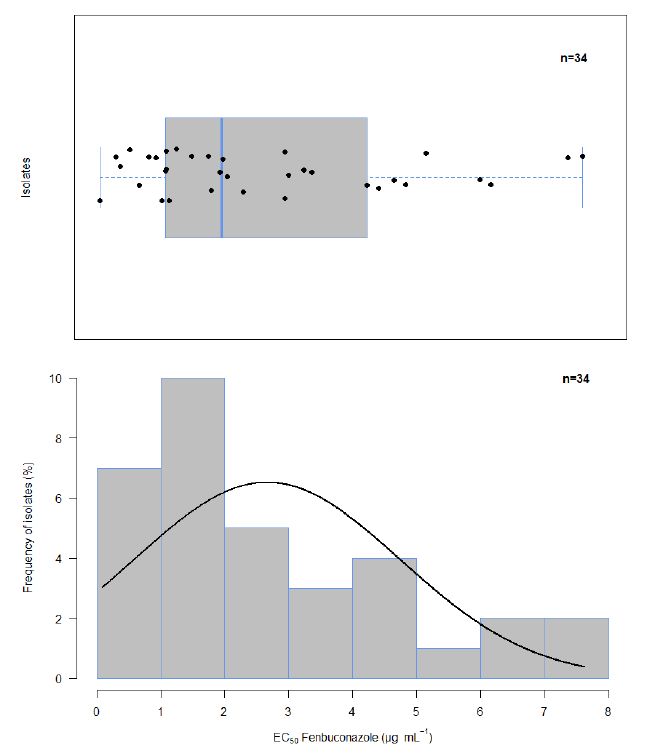
Figure 1. Box-whisker plot and frequency distribution of fenbuconazole sensitivity of Zasmidium citri-griseum isolates from Panama (n = 34) expressed as the effective concentration needed to reduce mycelial growth by 50% (EC 50